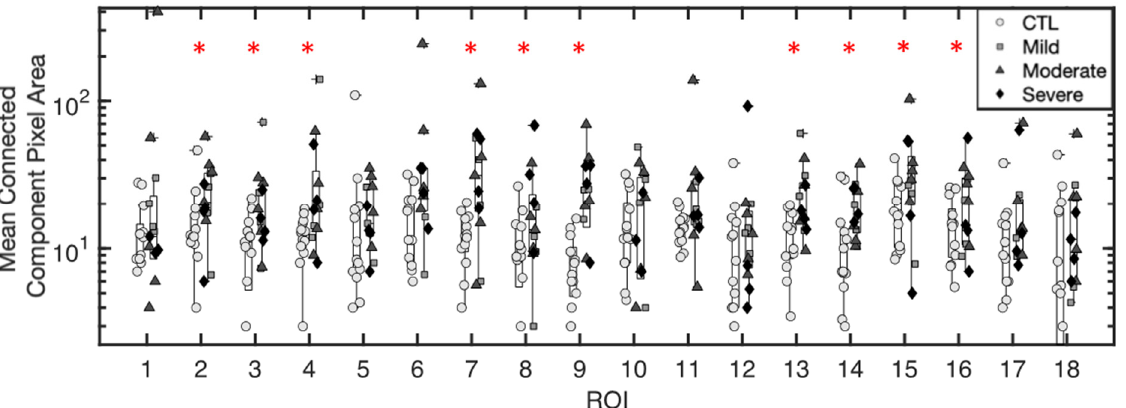
Figure 5. Mean connected component pixel area per ROI in control and CF subjects. ROIs 1–9 are from the right lung and ROIs 10–18 are from the left lung. Red asterisks denote a statistically significant increase in CF subjects when compared to controls ( p < 0.05). The mean connected component pixel area is plotted in log scale.